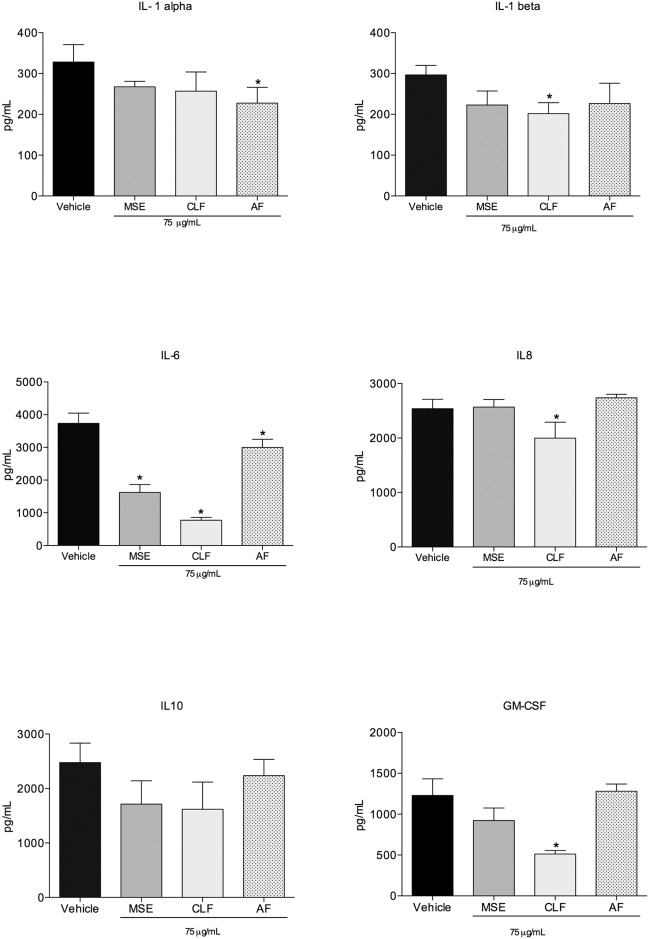
Cytokine assay.Quantification of IL-1alpha, IL-1beta, IL-6, IL-8, IL-10 and GM-CSF in the co-culture supernant after 24h of A. actinomycetemcomitans invasion. Cells were treated with 75μg/mL of MSE and fractions and bacteria inocula were established at 2x106 CFU/mL. Data are expressed as mean±SD, n = 6. Symbols indicate statistical differences (p<0.05, Dunnet’s test). # indicates p<0.05 compared to non-treated group; * indicates p<0.05 compared to vehicle group.